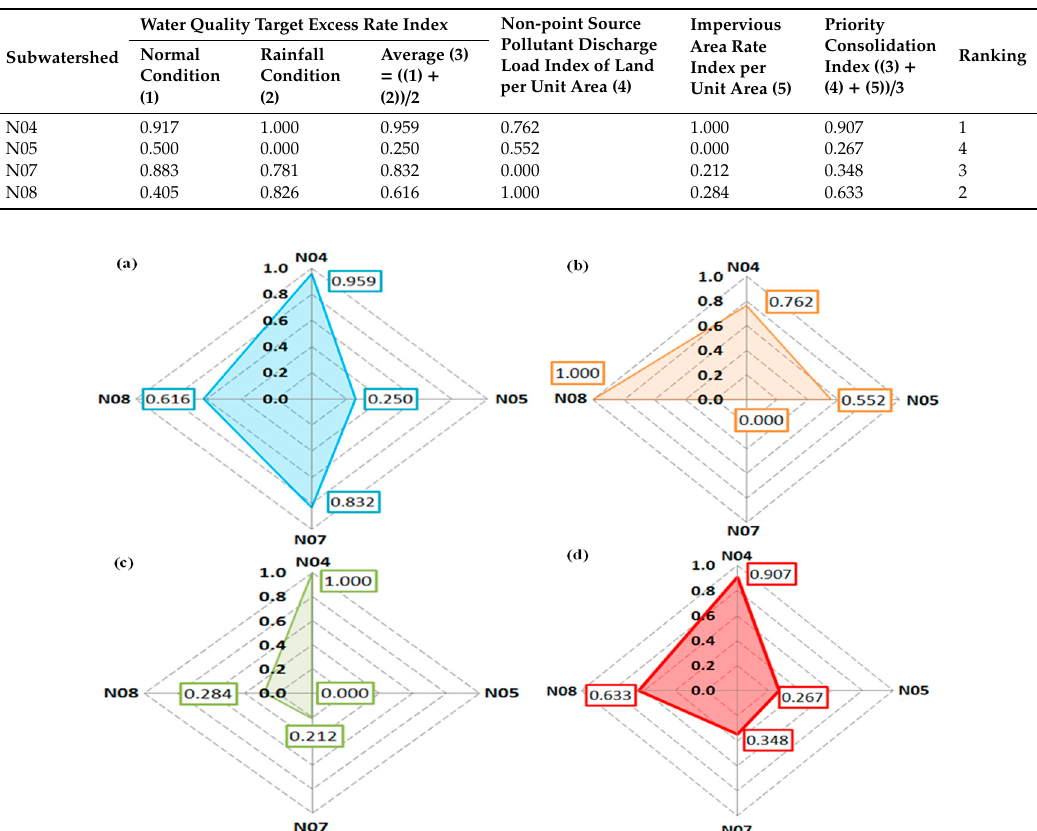
Figure 7. Prioritization methodology for TP management measures area. Table 2. Priority index analysis results.